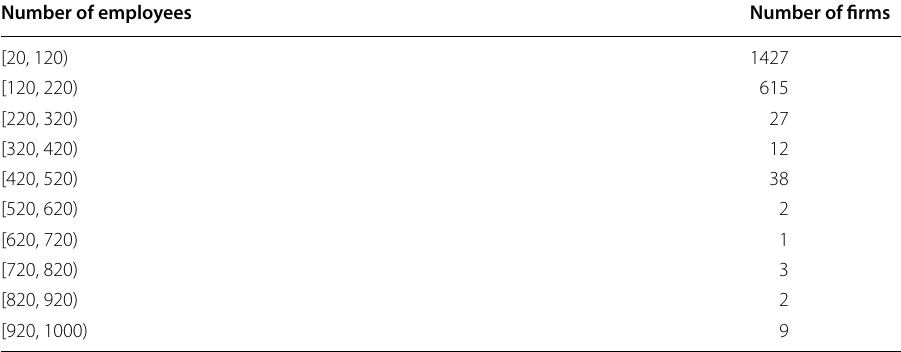
Table 7 Descriptive statistics of the number of employees